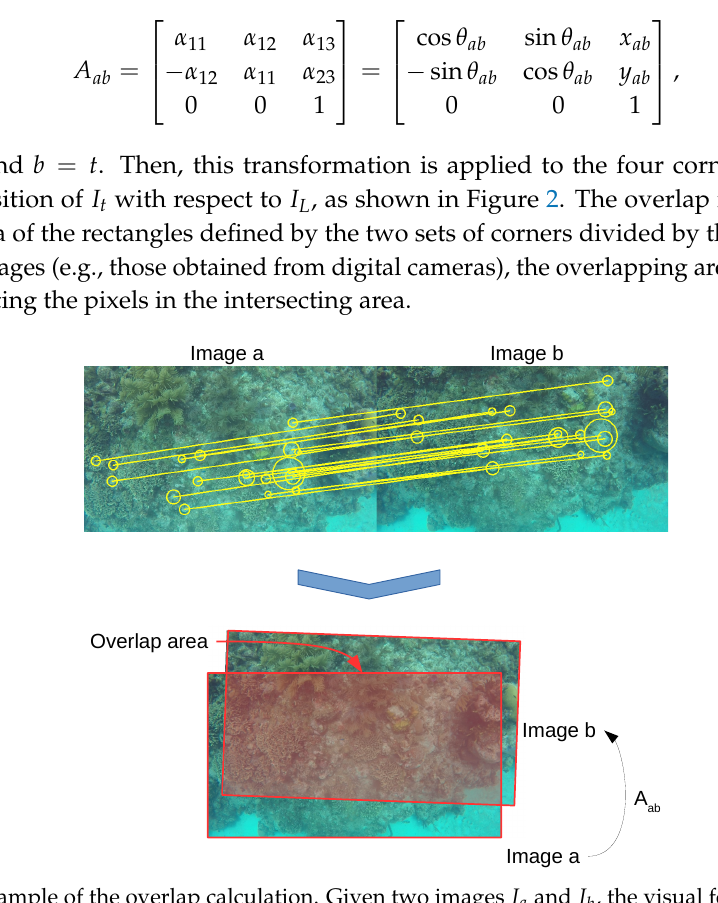
Figure 2. Example of the overlap calculation. Given two images I a and I b , the visual features between both images are matched. From those matches, a rigid transformation A ab is obtained. After that, we can calculate the intersection between both frames and its